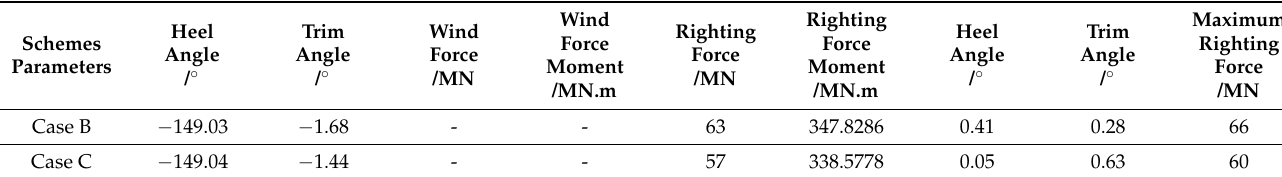
Table 5. Wind force and righting force of case